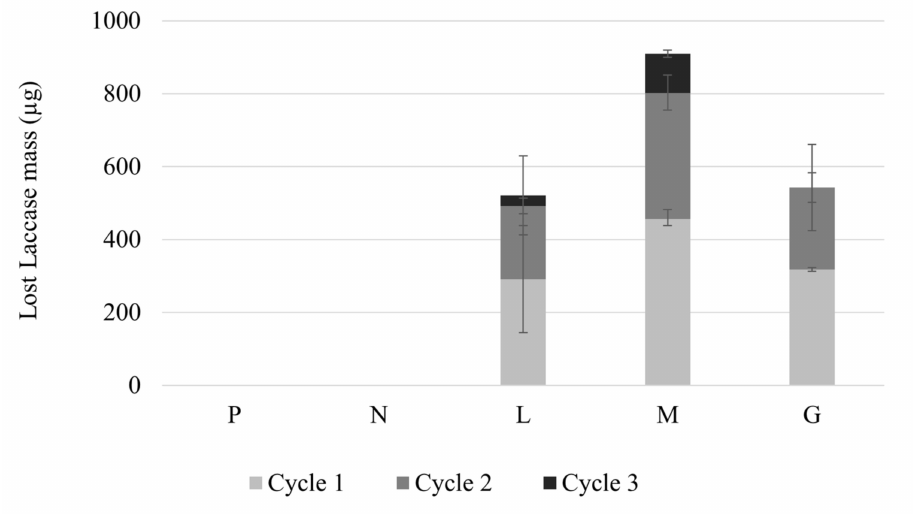
Figure 11. Lost Laccase per cycle using the different filters P, N, L, M and